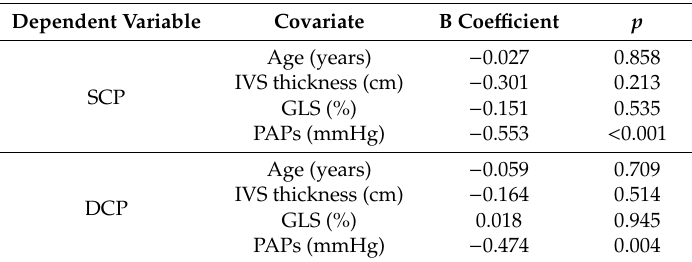
Table 4. Independent determinants of vessel density of SCP and DCP in whole image by multiple linear regression